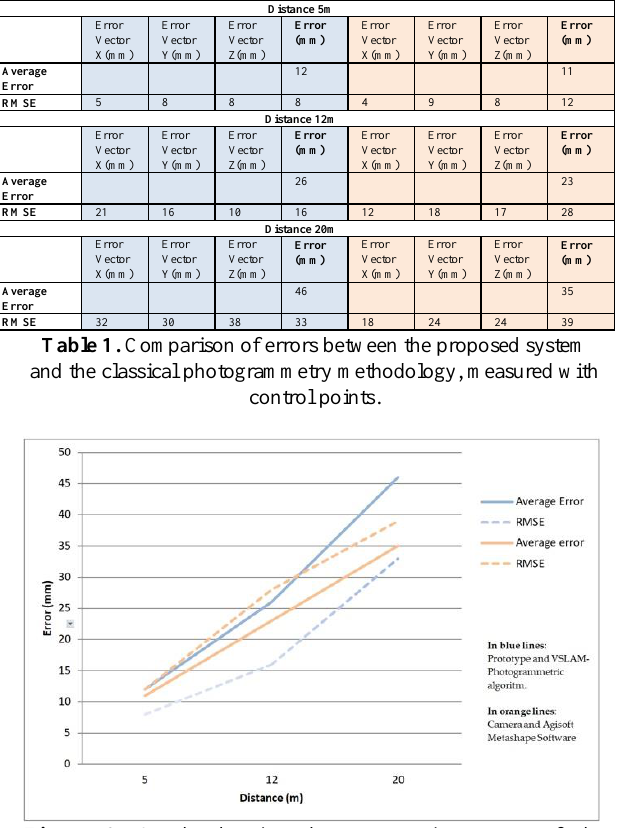
Figure 6. Graph showing the comparative errors of the proposed system and the classical methodology through the distance from the sensor to the monument.